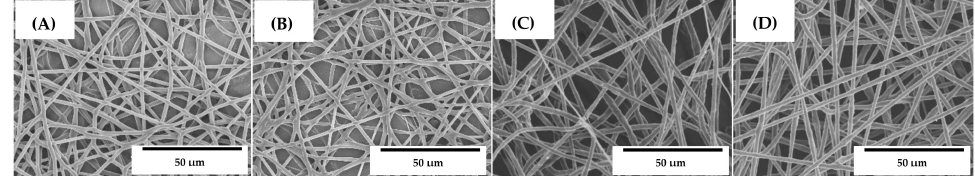
Figure 1. Scanning electron microscopy (SEM) micrographs of the electrospun fibers of: ( A ) Neat poly(3-hydroxybutyrate- co -3-hydroxyvalerate) (PHBV); ( B ) Oregano essential oil (OEO)-containing PHBV; ( C ) Rosemary extract (RE)-containing PHBV; ( D ) Green tea tree extract (GTE)-containing PHBV. Scale markers of 50 µ m.